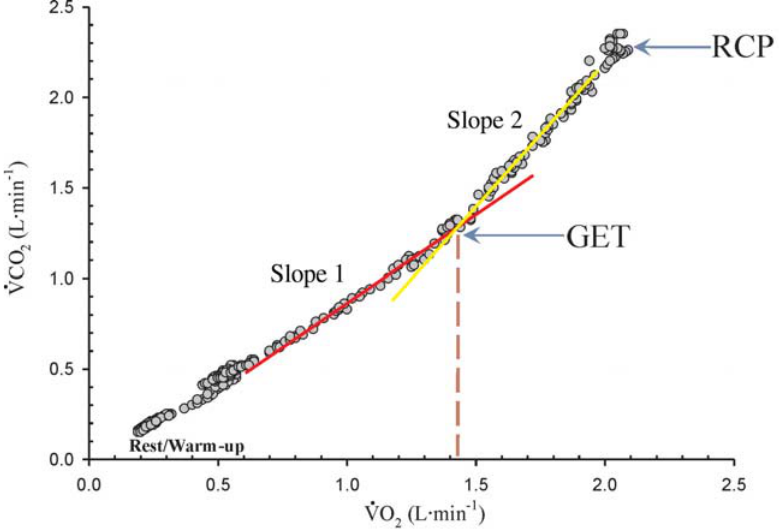
Figure 4 - Determination of GET by V-slope method ( (cid:57) (cid:115) (cid:38)(cid:50) above the respiratory compensation point (RCP), are not to be included in the regression analyses for the determination of the observed